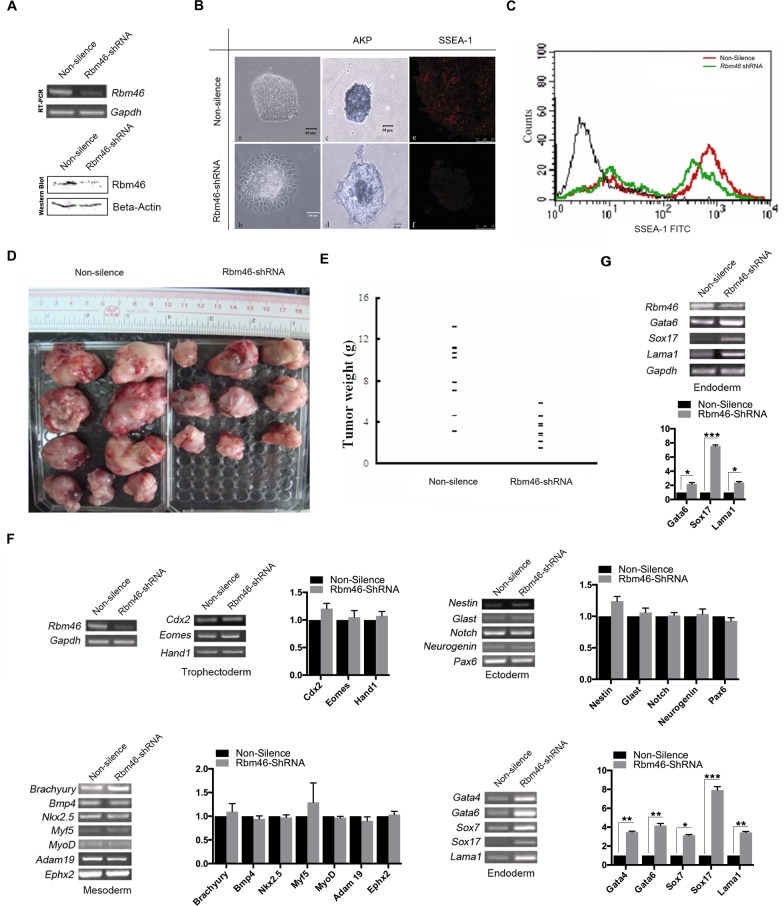
Downregulation of Rbm46 promotes differentiation of mESC into endoderm.(A) RT-PCR and Western Blot analysis of the Rbm46 shRNA-E14 stable cell lines. (B) Left panel shows the morphology of the Non-silence cells and Rbm46 shRNA cells. Middle panel shows the AKP staining and immunostaining with SSEA-1 antibody of Non-silence cells and Rbm46 shRNA cells. (C) FACs analysis of the SSEA-1 positive cells in Non-silence cells and Rbm46 shRNA cells. (D) and (E) Representative images and tumor weight analysis of the teratocarcinoma formed by Non-silence cells and Rbm46 shRNA cells. (F) RT-PCR analysis of mRNA level of the marker from different layers in Non-silence cells and Rbm46 shRNA cells. The columns show the quantification of the indicated gene relative to Gapdh. The average value in the Non-silence group is normalized as 1. Experiment was performed in triplicate. Error bars showed the standard deviation. *, p<0.05; **, p<0.01; ***, p<0.001; t-test. (G) RT-PCR analysis of the endoderm markers expressed in the teratocarcinoma formed by Rbm46 shRNA cells. The columns show the quantification of the indicated gene relative to Gapdh. The average value in the Non-silence group is normalized as 1. Experiment was performed in triplicate. Error bars showed the standard deviation. *, p<0.05; ***, p<0.001; t-test.